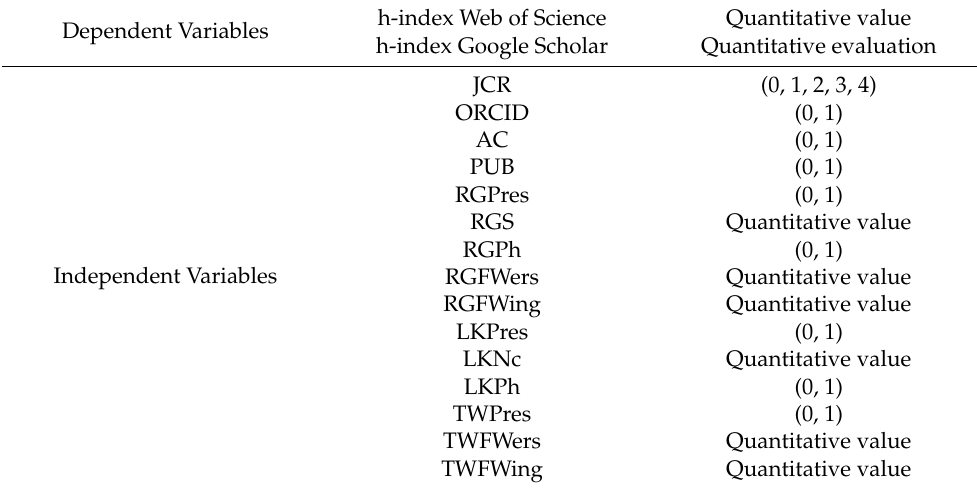
Table 2. Variables used in the